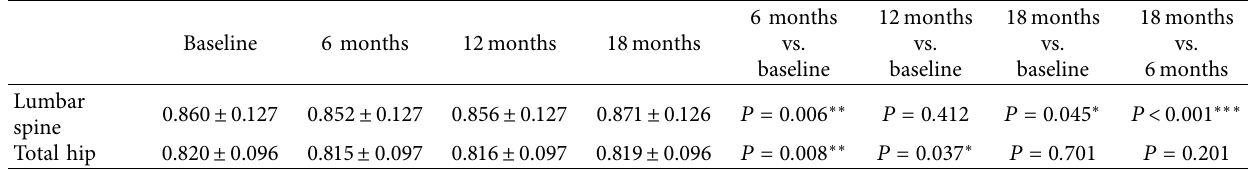
Figure 1: Serum IGF-1 changes over the 18-month treatment period. Te results are presented as the mean ± SE. ∗ P < 0 . 001 compared with the baseline (student’s t -test). Table 2: Changes in BMD during 18months of rhGH replacement